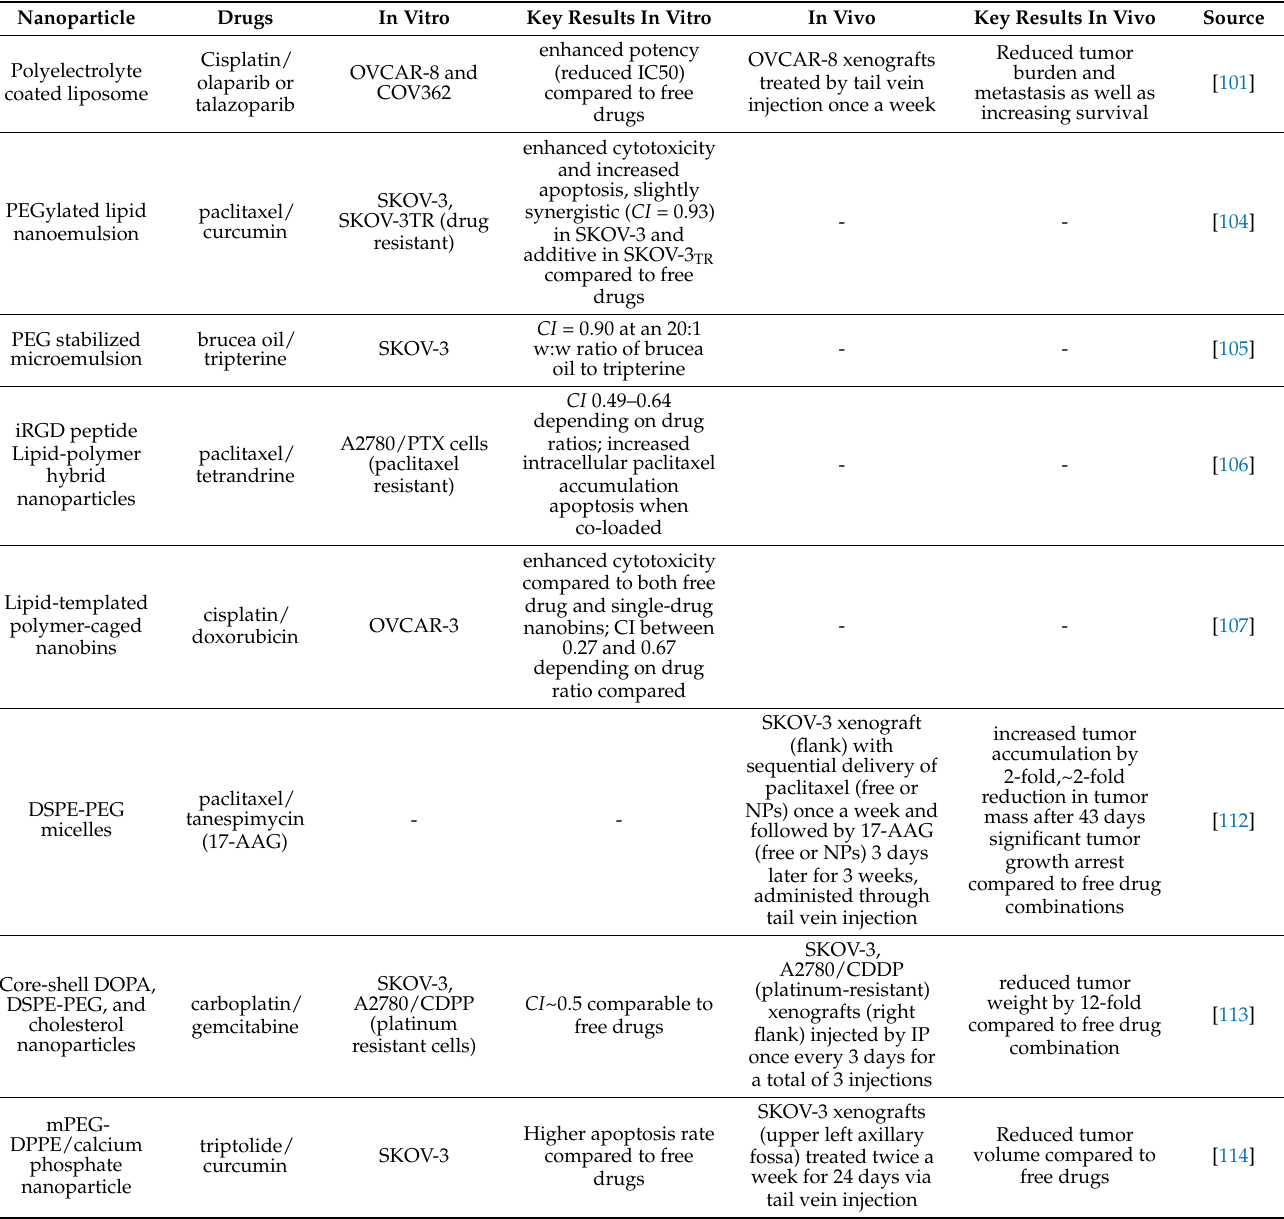
Table 4. Lipid-polymer nanocarriers for co-delivery of anticancer